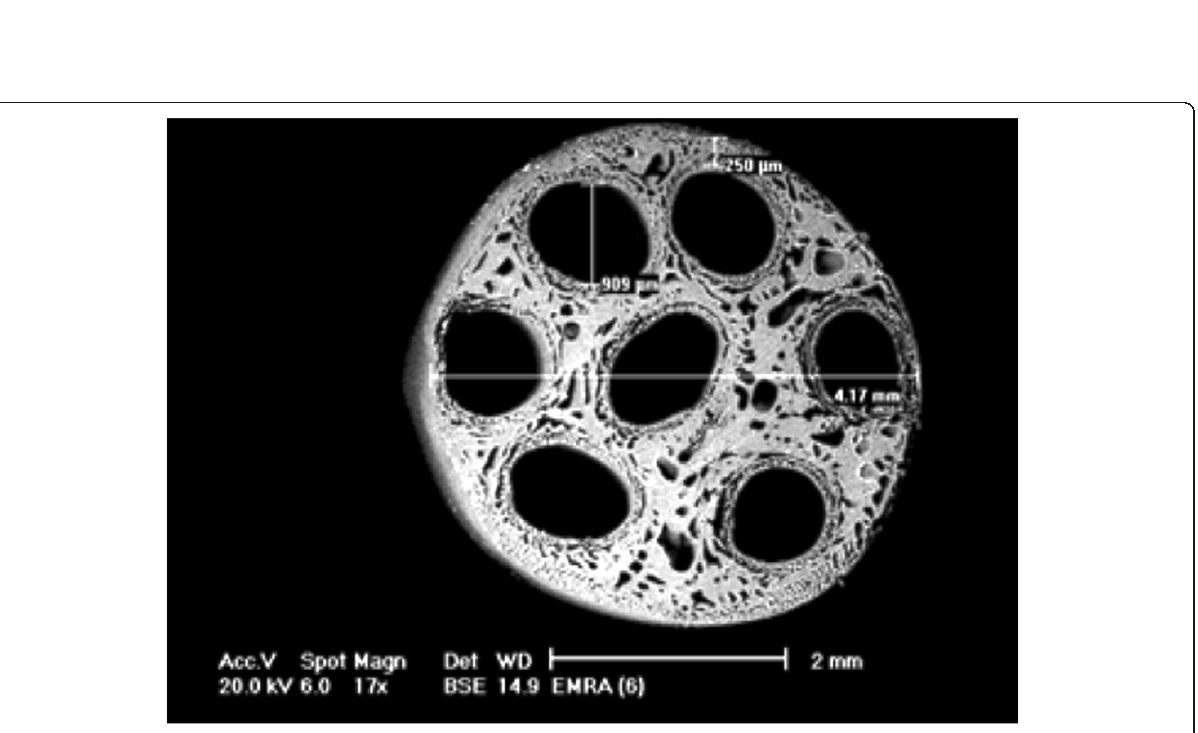
Fig. 17 SEM of the PVDF hydrophobic porous